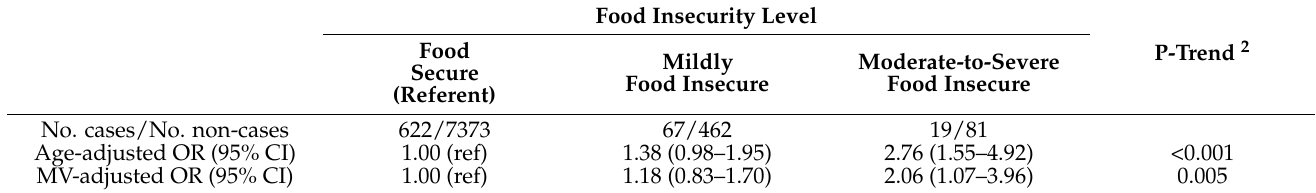
Table 3. Age- and multivariable-adjusted 1 odds ratios (95% confidence intervals) of low muscle strength according to food insecurity levels.